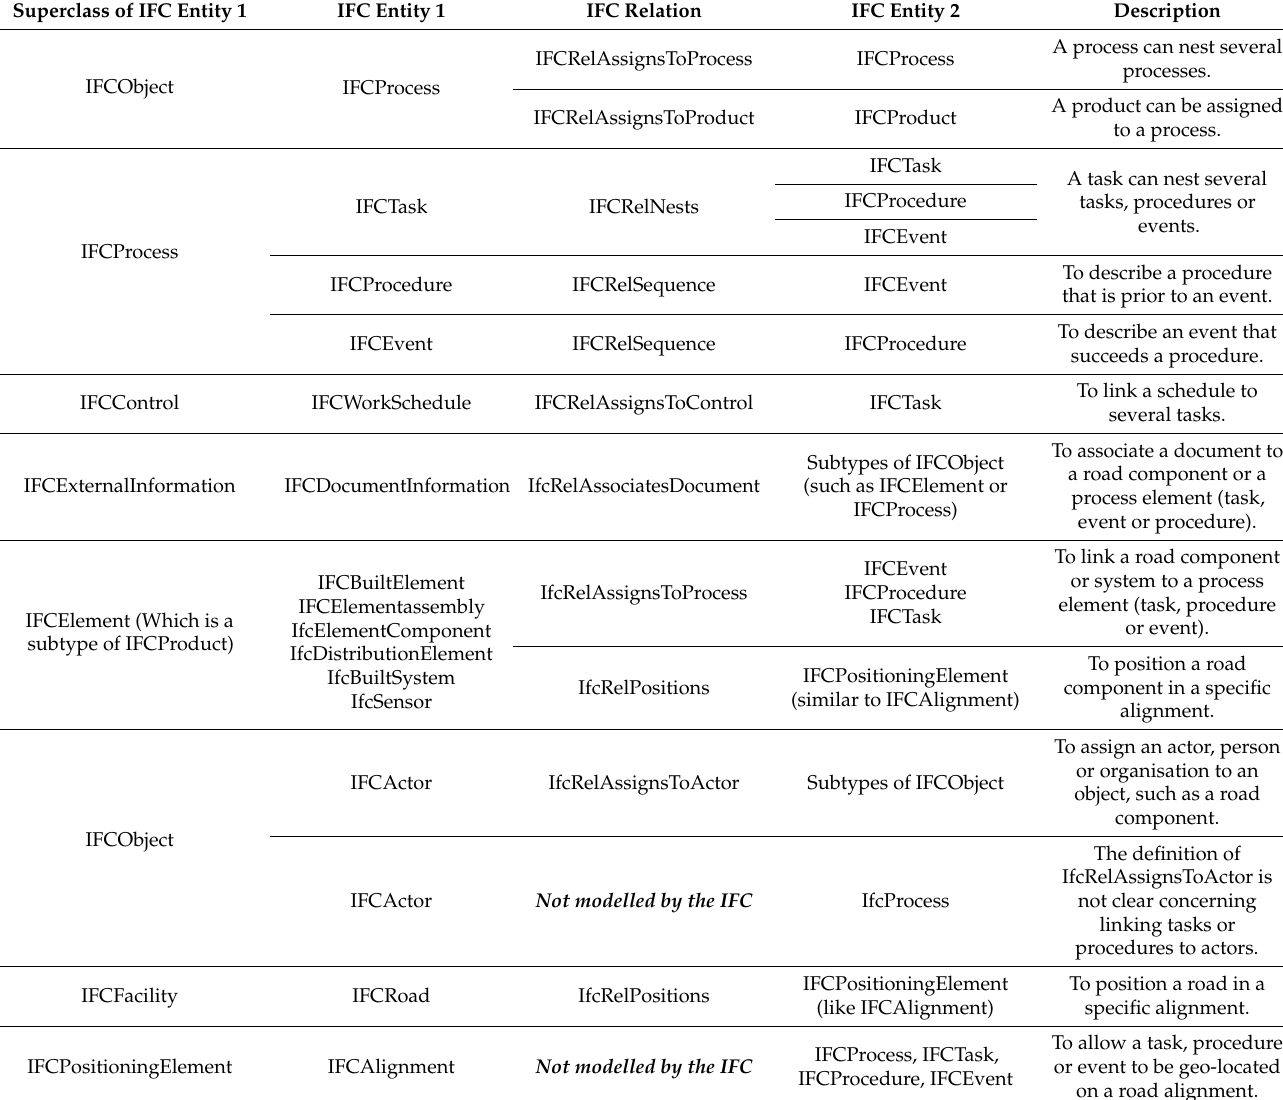
Table 2. Extract of O&M process modelling capabilities of IFC